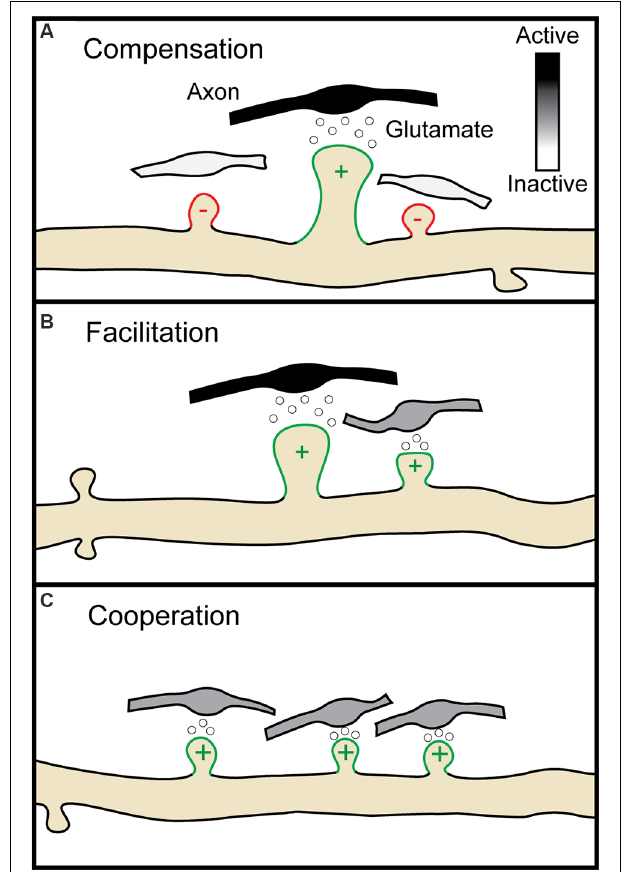
FIGURE 2 | Multiple forms of heterosynaptic plasticity. (A) Homosynaptic potentiation at a single synapse (green spine, +), represented here by the release of glutamate from an active presynaptic axon (black boutons), results in compensatory heterosynaptic depression of nearby inactive synapses (white boutons, red spines, − ). (B) Homosynaptic potentiation at one spine can facilitate later potentiation at a neighboring spine receiving a subthreshold stimulus (gray bouton). (C) Four neighboring spines receiving subthreshold stimulation undergo potentiation through cooperative heterosynaptic